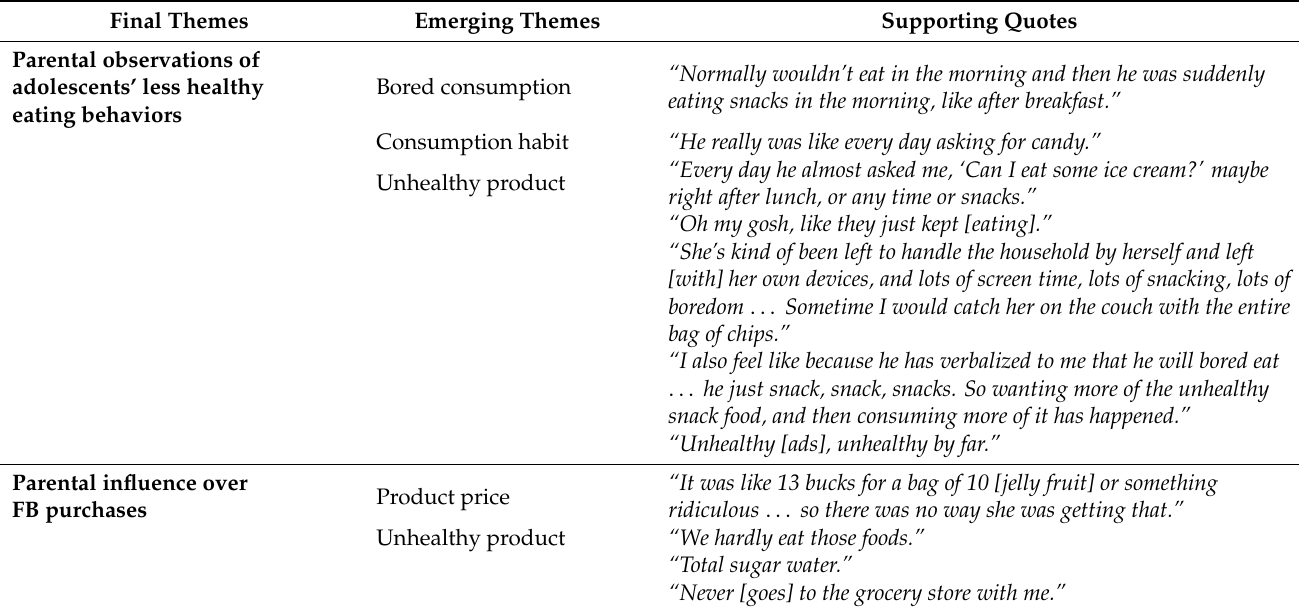
Table 6. Adolescent Qualitative Themes (n =